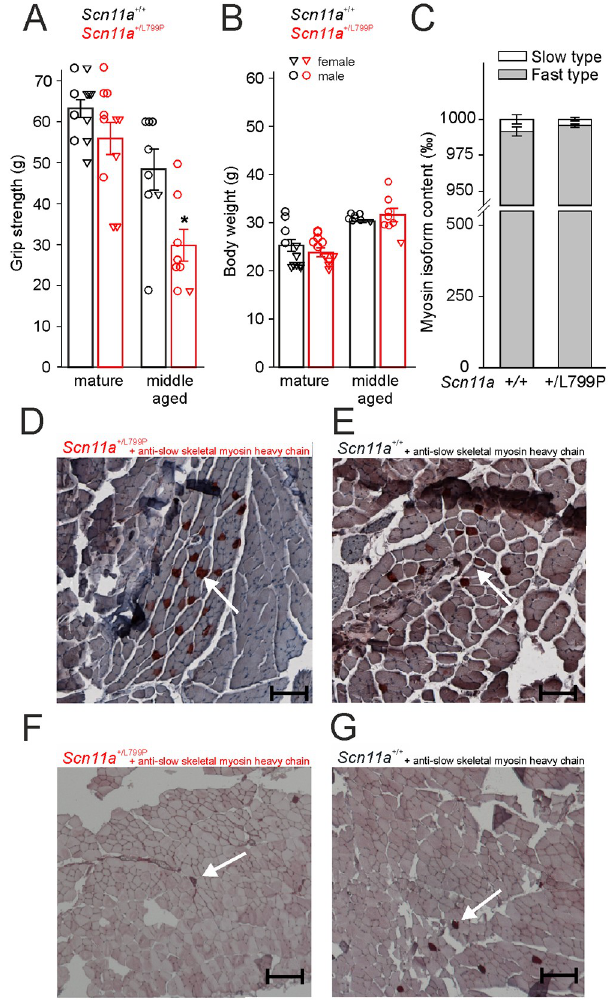
Fig 4. Quantification of grip strength and muscle fiber histology. (A) Middle aged (9–10 months) but not mature adult (3–7 months) Scn11a +/L799P mice showed a significant decrease in grip strength compared to age-matched Scn11a +/+ littermates (n = 8–11 per group). (B) Both genotypes did not differ in their body weights (n = 8–11 per group). (C) Both genotypes also did not differ in the composition of slow and fast type muscle fibers of the Musculus tibialis cranialis (n = 6 per group; all Scn11a +/+ mice and 4 out of 6 Scn11a +/L799P used for muscle histology were also used for grip strength testing). (D, E) Representative images of muscle fiber staining using anti-slow skeletal myosin heavy chain antibody of cross sections of the forelimbs of Scn11a +/L799P mice (D) and Scn11a +/+ mice (E) (bar 200 μ m) showing positively labeled slow (type 1) myosin isoform muscle fibers (marked by arrows). (F, G) Muscle fiber staining using anti-slow skeletal myosin heavy chain antibody of cross sections of the Musculus tibialis cranialis of Scn11a +/L799P mice (F) and Scn11a +/+ mice (G) (bar 200 μ m). Values are mean ± SEM. � p <